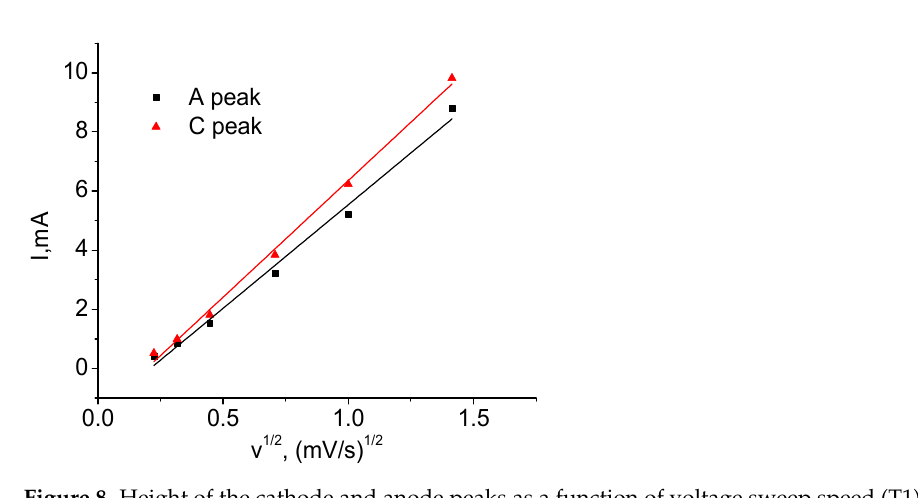
1.03 is changed. This corresponds to a decrease in height of the cathode peak 1.03 with its simultaneous shift towards higher voltages so that by cycle 5, it looks like a small shoulder. At the same time, the 0.88 cathode peak and the 2 V anode peak just slightly change their voltage position. With an increasing number of cycles, an additional 0.6 V anode peak and 2.02 V cathode peak appear.